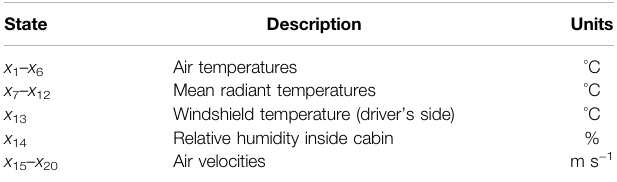
TABLE 3 | Measurement variables comprising the state x . Personal variables (air and mean radiant temperature and air velocity) are measured at the